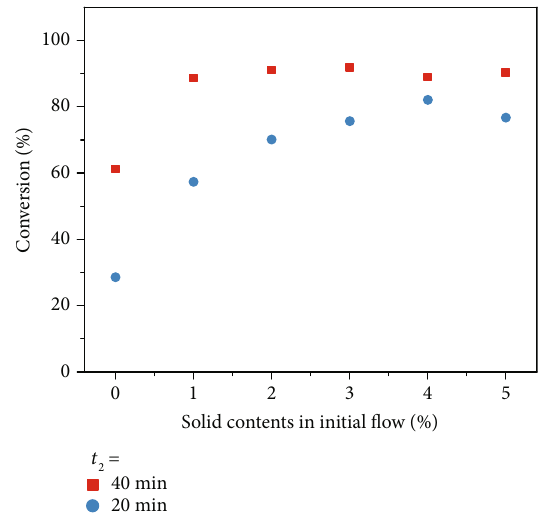
Figure 9: E ff ect of the solid content in the initial microemulsion on the monomer conversion ( W : O = 1 : 5 : 1 , T = 80 ° C, t 1 = 20 min, and the concentration of APS was 5mM).